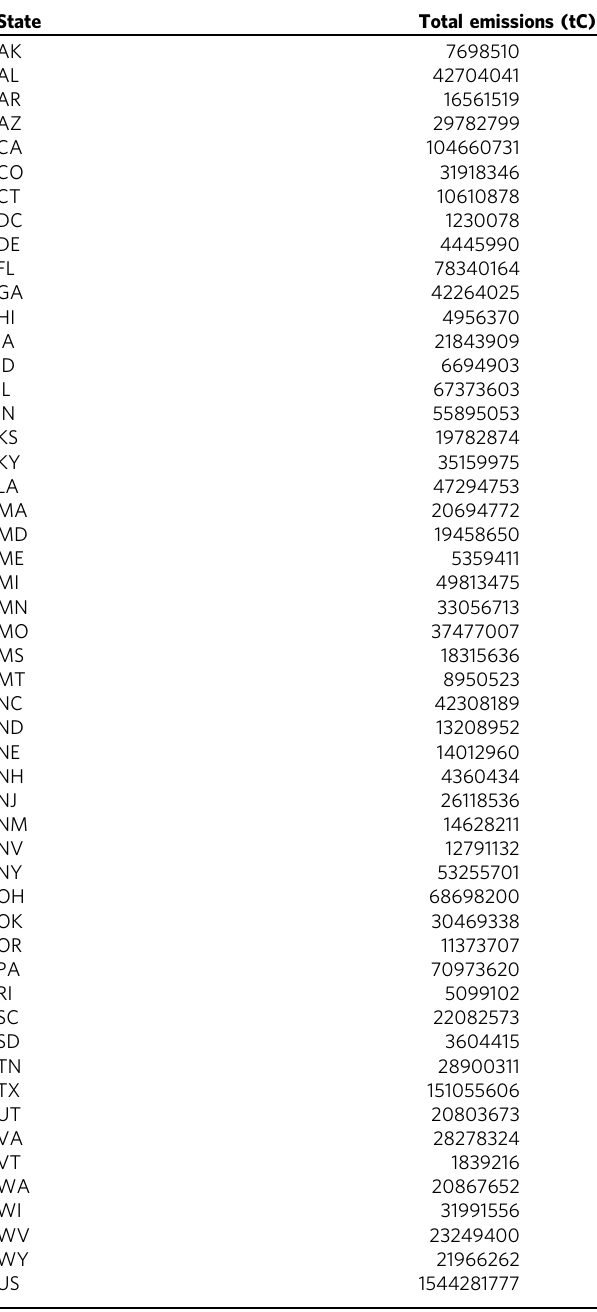
Table 1 State total FFCO 2 + cement production emissions for the year 2015 as generated by Vulcan version 3.0 10